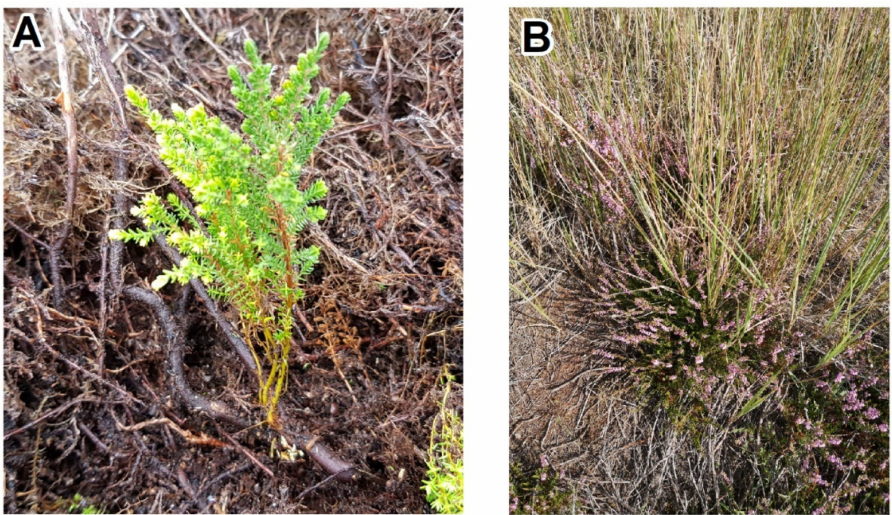
Figure 2. ( A ) resprouting of Calluna vulgaris from buds located at the stem base of parental